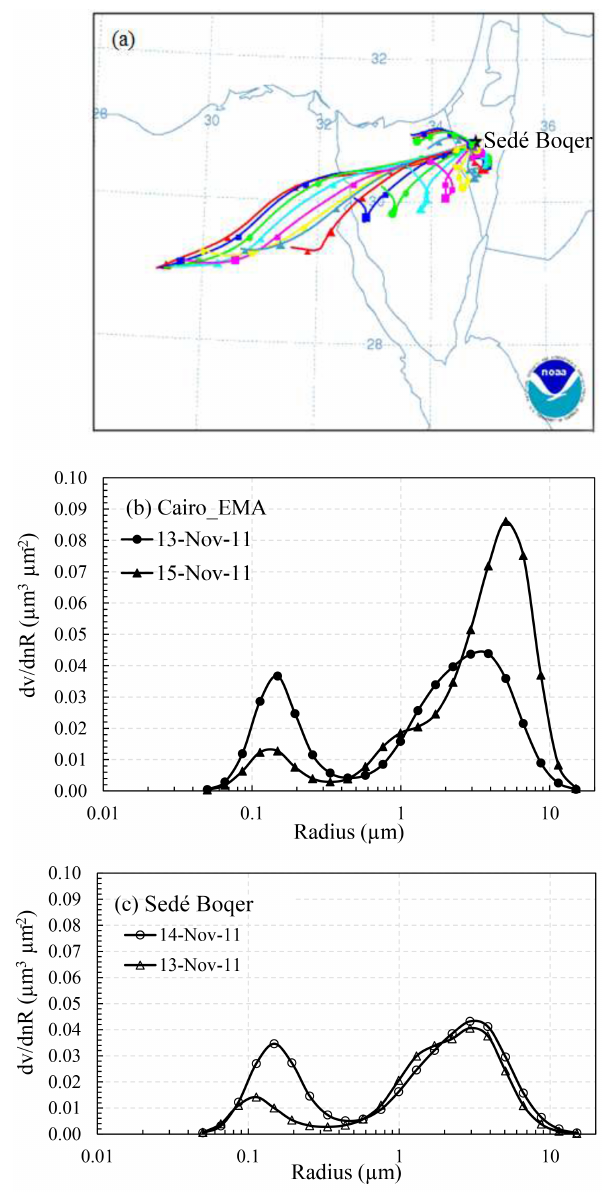
Figure 5. (a) HYSPLIT backward trajectory on 14 November 2011 at Sedé Boqer site showing aerosol possible transport from Cairo site; (b) volume size distribution at Sedé Boqer site during 13 and 14 November 2011; (c) volume size distribution at Cairo_EMA site during 13 and 15 November